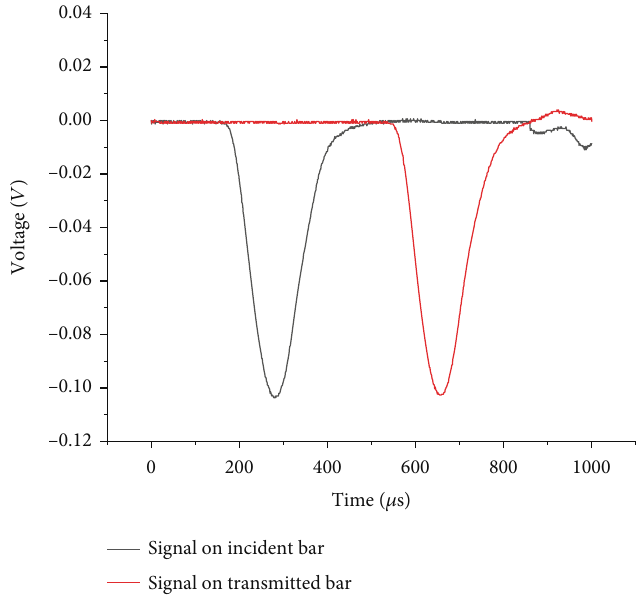
Figure 3: Electrical signals of